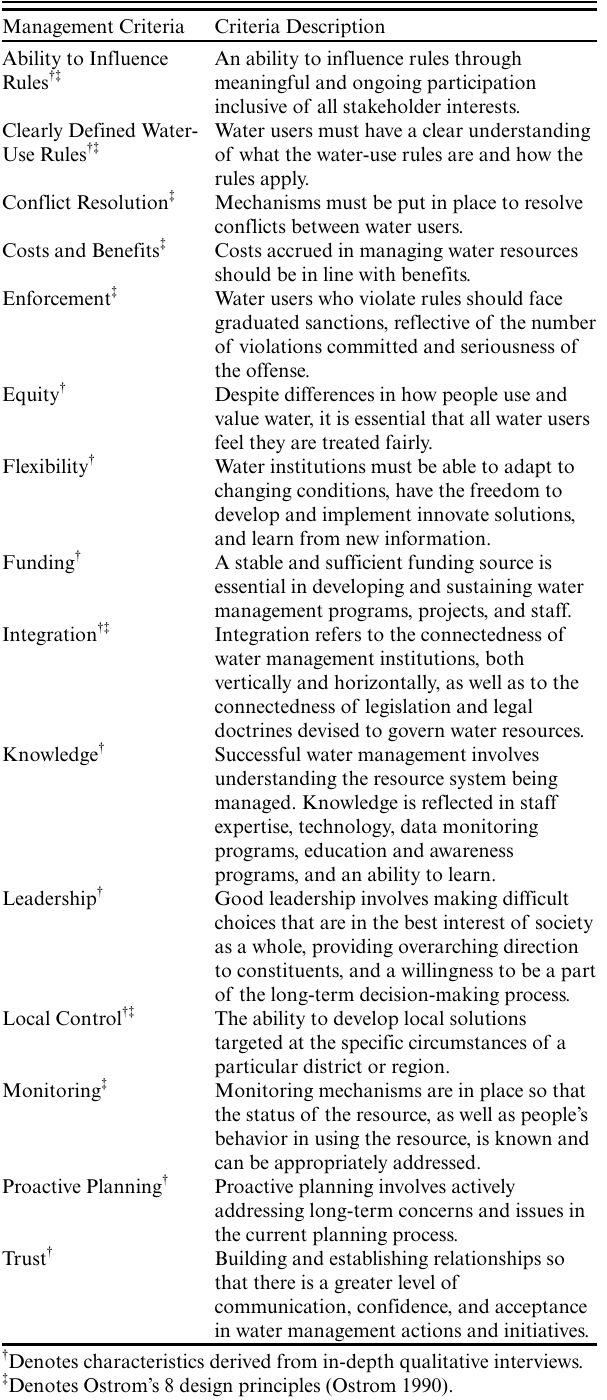
Table 1 . Characteristics promoting successful water